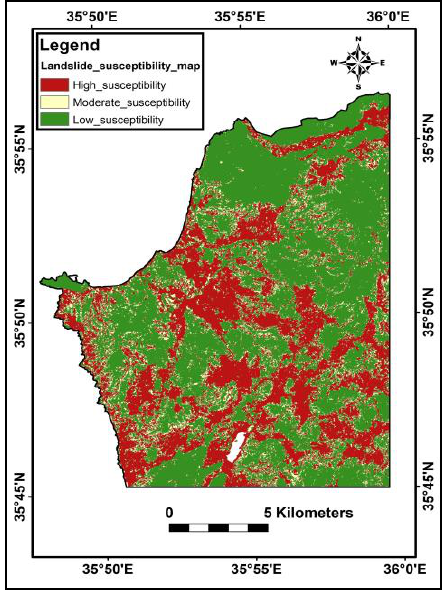
Figure 11. The landslide susceptibility map of the study area using ANN analysis.